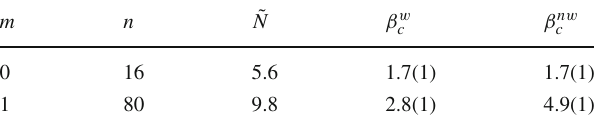
Table 5 β c -values for the weighted and not-weighted Volleyball dis- cretisation V m for 0 ≤ m ≤ 1 determined for d = 4 on 10 4